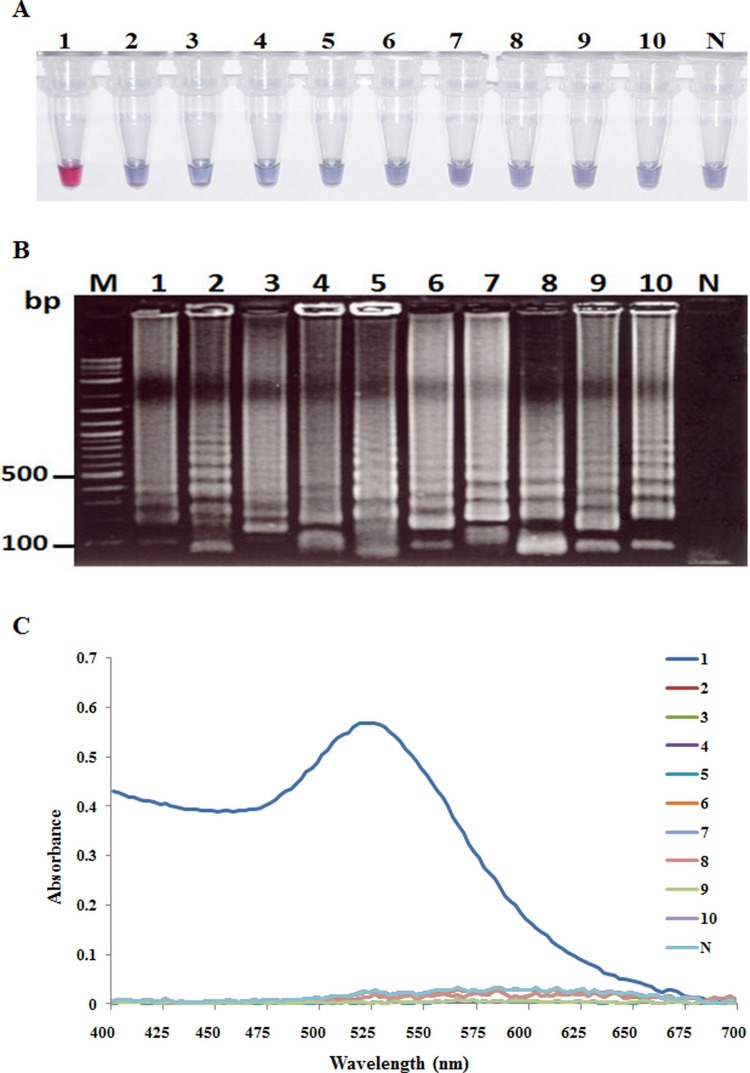
Comparison of results obtained using the VPAHPND AuNP hybridization probe with LAMP amplicons from VPAHPND (Lane 1) and other common pathogens (Lanes 2–10).(A) The result of agarose gel electrophoresis (AGE) of LAMP products from various pathogens. Lane M: 2 log DNA marker; Lane N: normal shrimp DNA as negative control; Lanes 2–10: TB, Plasmodium (Malaria), WSSV, YHV, IMNV, IHHNV, TSV, LSNV and PemoNPV, respectively. (B) Colorimetric result for the same LAMP products as in Fig 7A measured after salt addition. (C) UV-visible spectra analysis corresponding to the individual tubes in Fig 7B measured after salt addition.